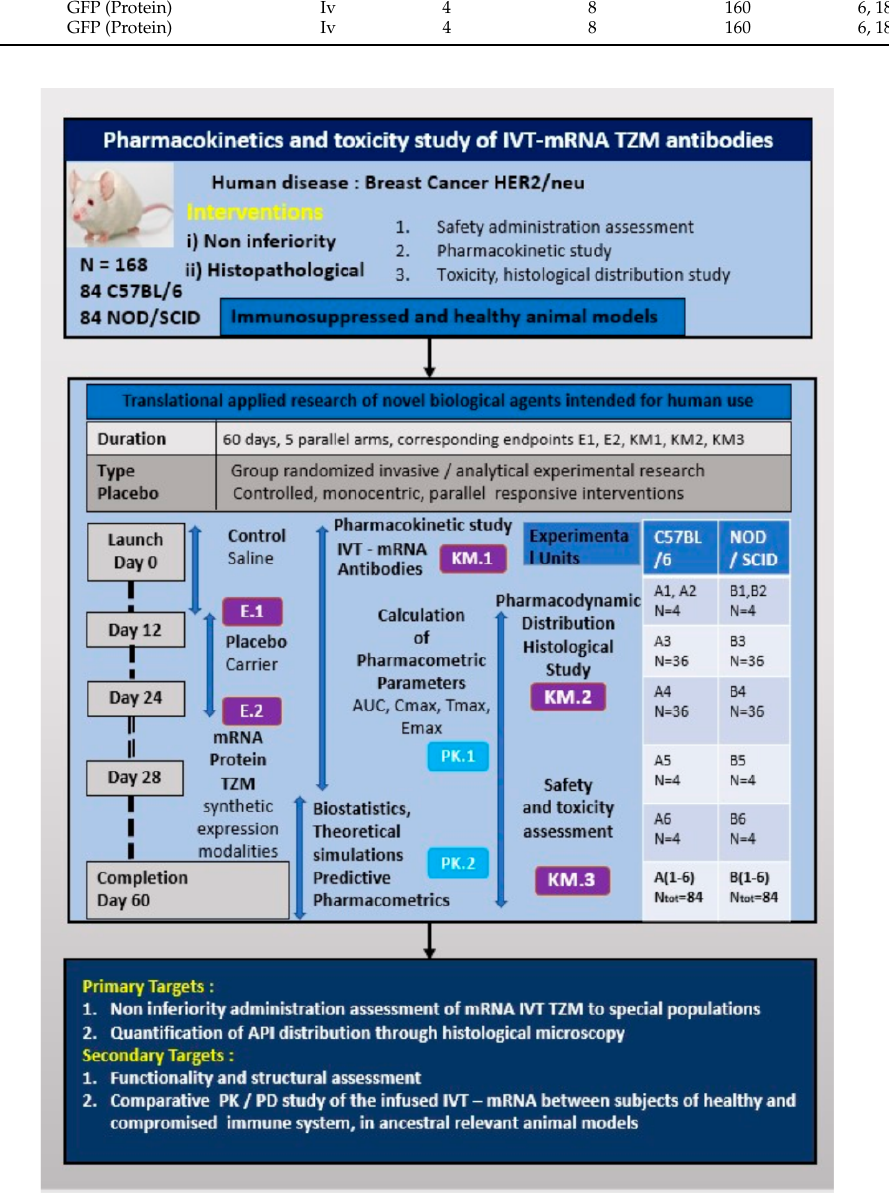
Figure 2. Overview of the pre-clinical trial design